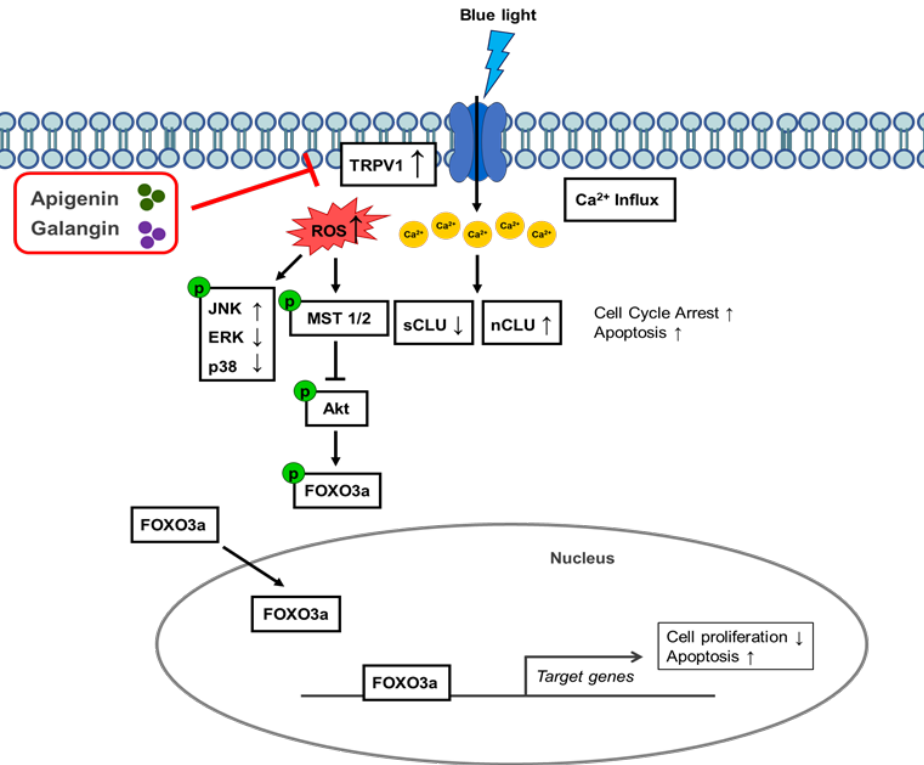
Figure 7. Schematic diagram showing action mechanism of apigenin and galangin in blue light- irradiated human keratinocytes.